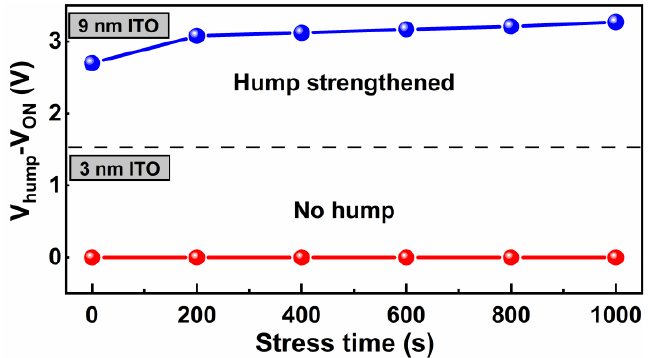
Figure 10. PBS stability for ZnO/ITO TFTs with t ITO values of ( a ) 3 and ( b ) 9 nm. The t ZnO is 25 nm.